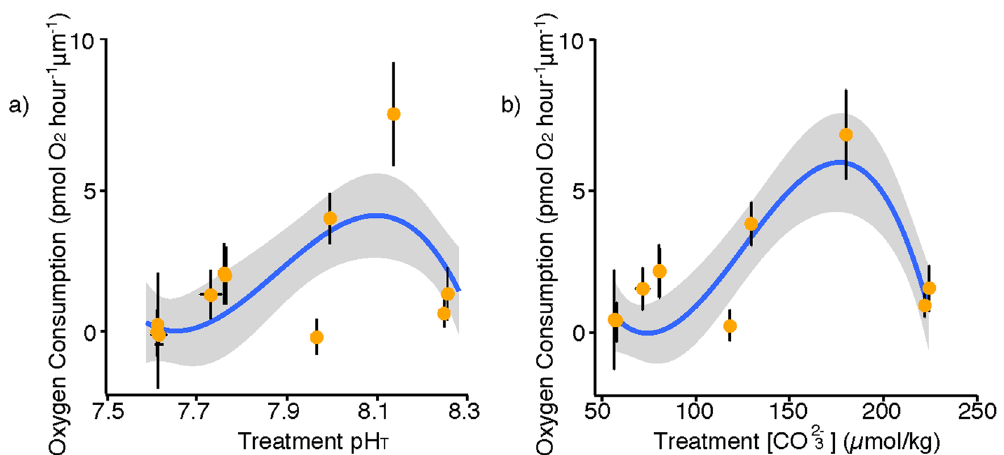
Figure 4. Oxygen consumption of Globigerina bulloides in response to changing carbonate chemistry conditions. Average rate of oxygen consumption for foraminifera over 24 hours, normalized to the longest shell diameter relative to the ( a ) pH and ( b ) [CO 32 − ] of exposure conditions (data for individual foraminifera can be found in Supplementary Data). Error bars show standard deviation in both the x and y directions. Data are fit with a 3 rd order polynomial with a 95% confidence